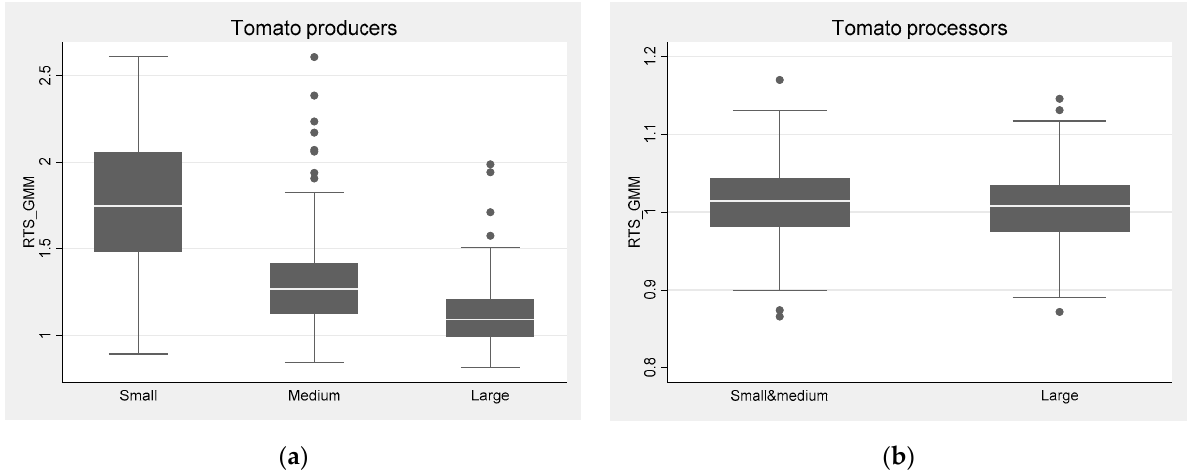
Figure 4. Distribution of returns to scale; ( a ) tomato producers and ( b ) tomato processors. Source: authors’ calculations.